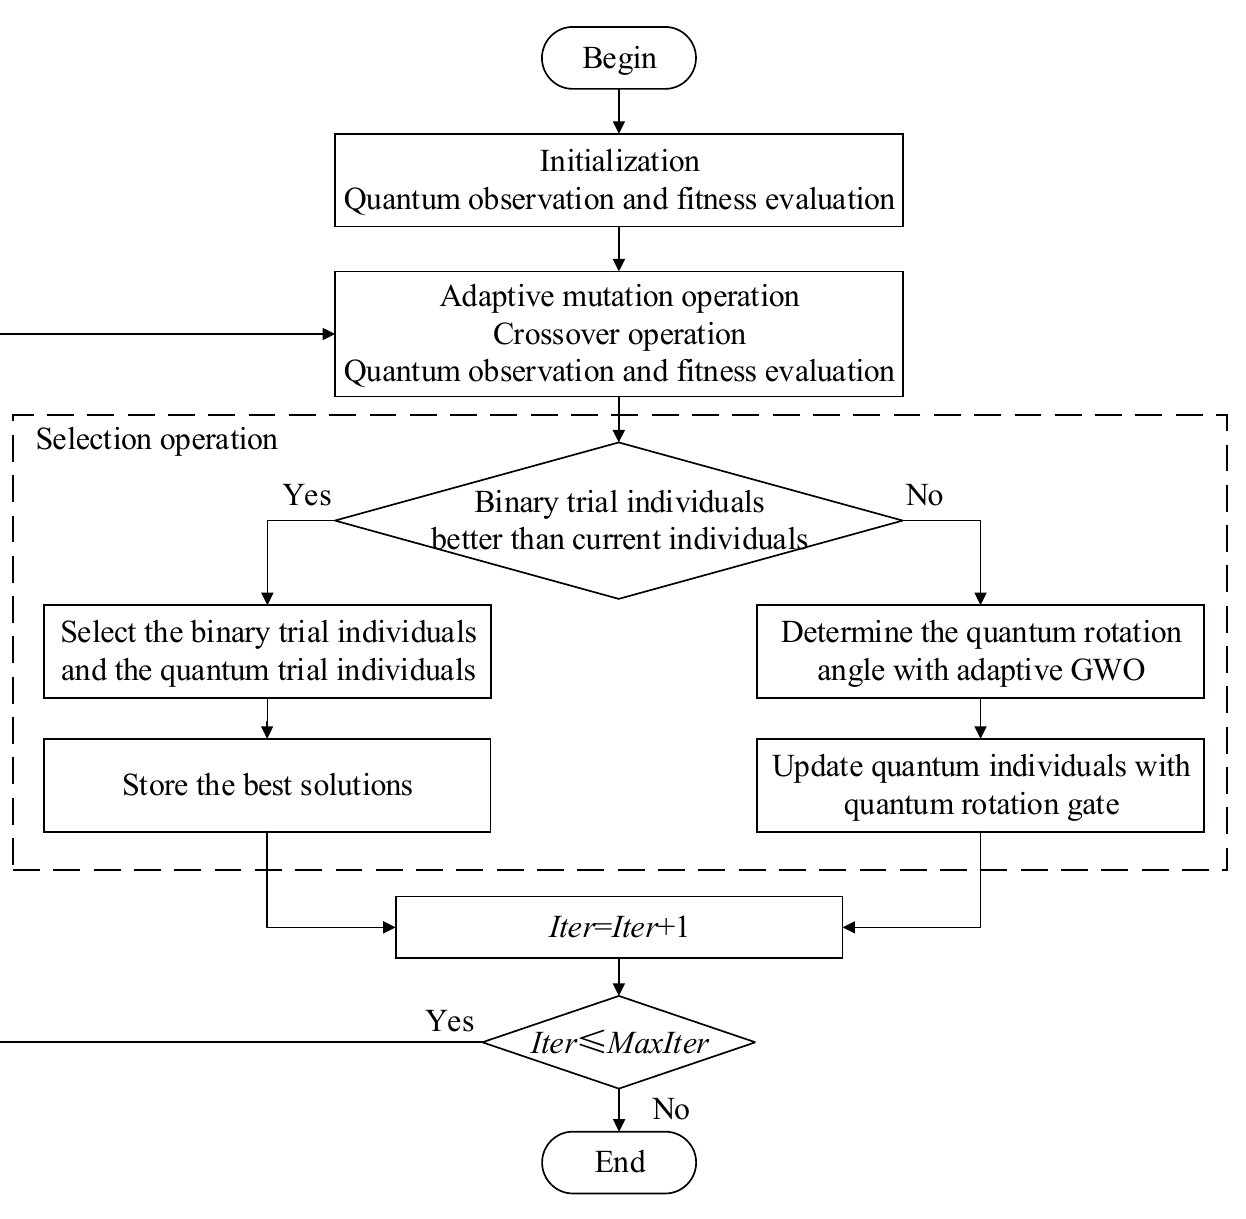
Figure 2. Framework of QDGWO.